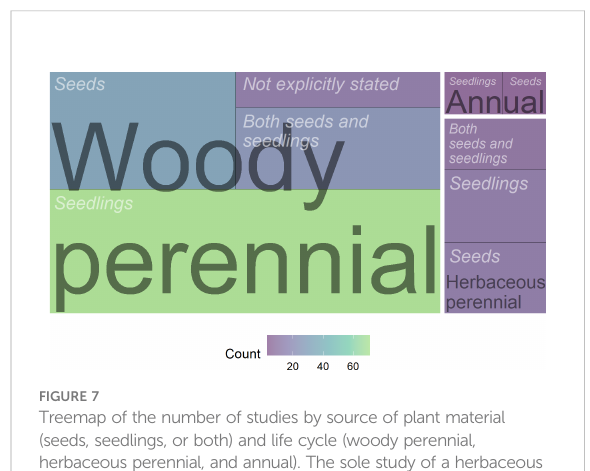
FIGURE 7 Treemap of the number of studies by source of plant material (seeds, seedlings, or both) and life cycle (woody perennial, herbaceous perennial, and annual). The sole study of a herbaceous biennial started using seeds is omitted from this visualization.